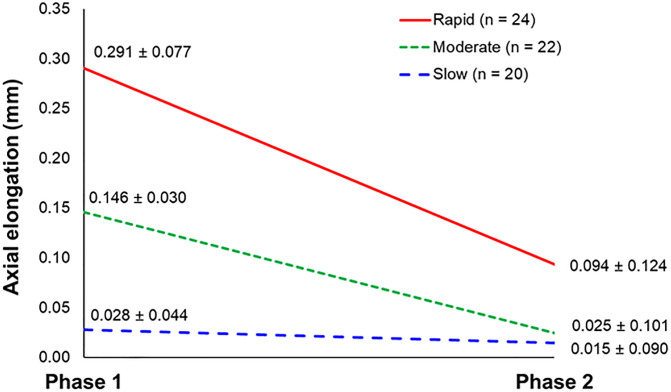
Mean (± standard deviation) axial elongation (AE) in Phases 1 (spectacle-wear phase) and 2 (orthokeratology phase) of various progressing groups, defined by AE in Phase 1.